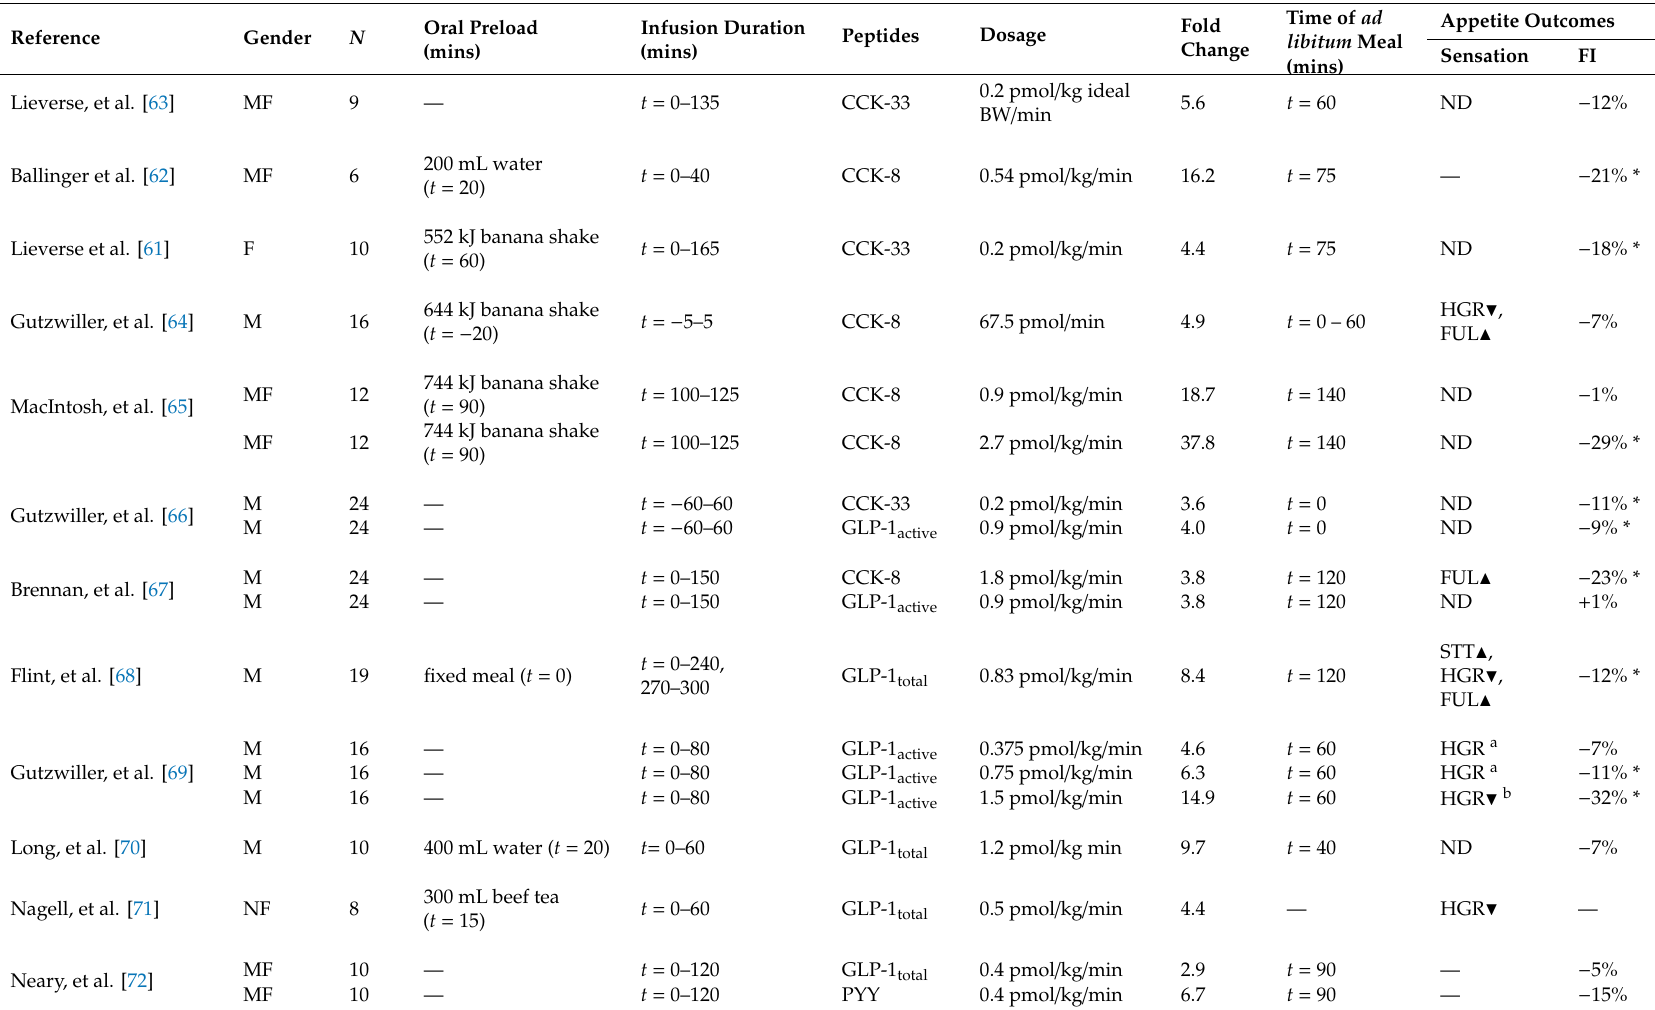
Table 2. Peptide infusion (INFUSION) studies in lean men and